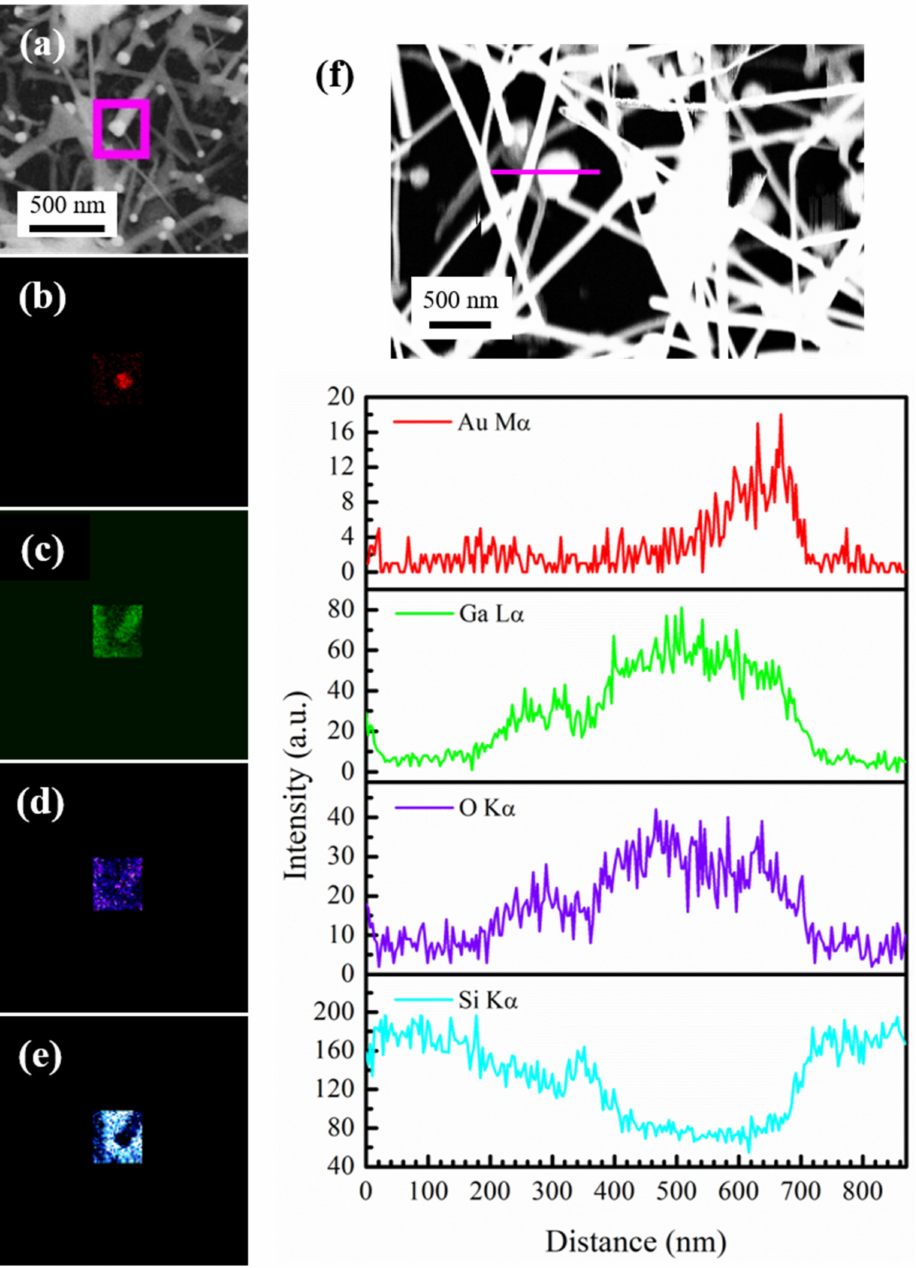
Figure 4. ( a ) FESEM image of β -Ga 2 O 3 NWs grown at 1000 ◦ C and EDX elemental mapping for ( b ) Au (red, M α ), ( c ) Ga (green, L α ), ( d ) O (purple, K α ), ( e ) Si (cyan, K α ) over the area marked by the square box in magenta in ( a ), and ( f ) EDX line scan across a nanoparticle on the tip of a nanowire as indicated by the magenta line in the FESEM image of β -Ga 2 O 3 NWs grown at 1100 ◦